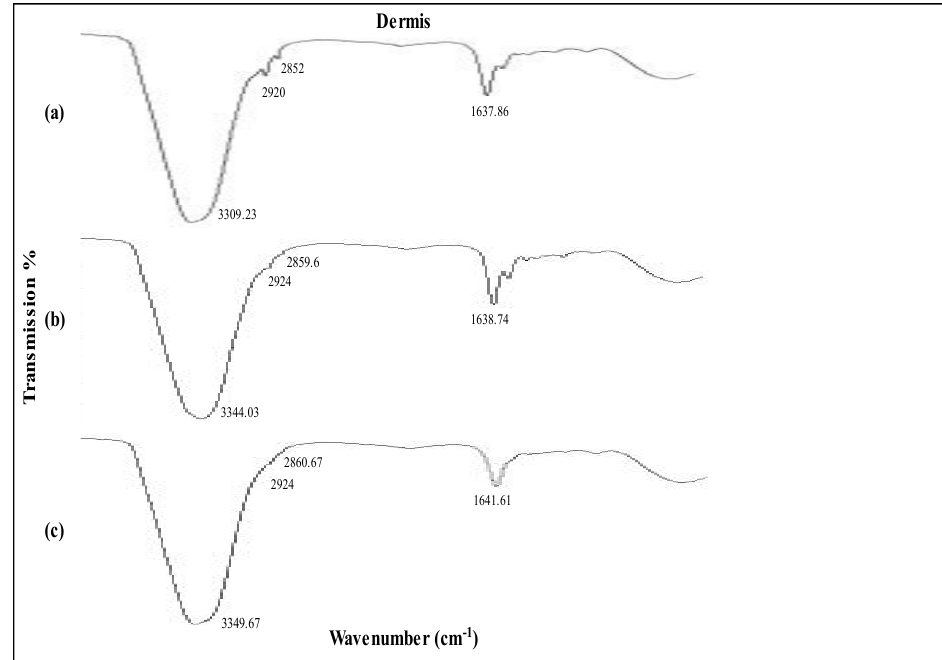
Figure 7. IR spectroscopy images of dermis ( a ) untreated skin and skin loaded with ( b ) MTX plain gel and ( c ) MTX NEG.